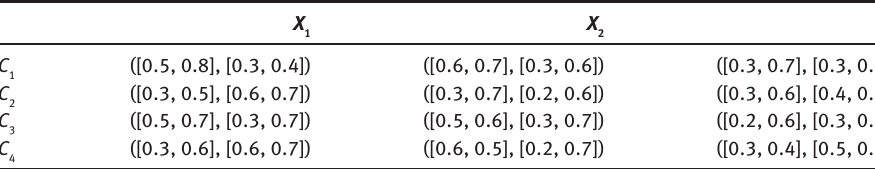
Table 1: Interval-Valued Pythagorean Fuzzy Decision Matrix of D 1 .